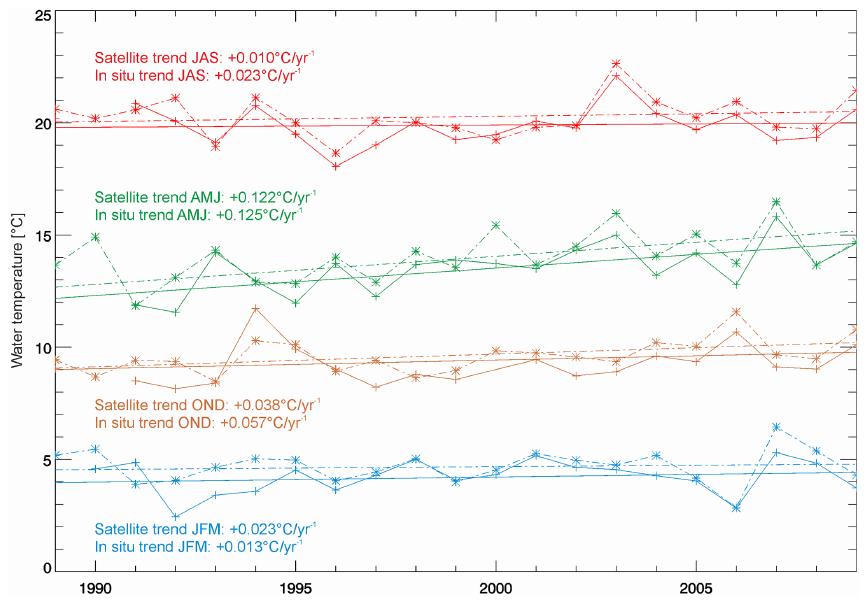
Figure 9. Seasonal mean water temperature and linear trends derived from in situ (dash-dotted) and satellite (solid) observations at Lake Constance for the period 1989 to 2009. Seasons are defined as JFM (January-February-March, winter), AMJ (April-May-June, spring), JAS (July-August-September, summer), and OND (October-November-December,